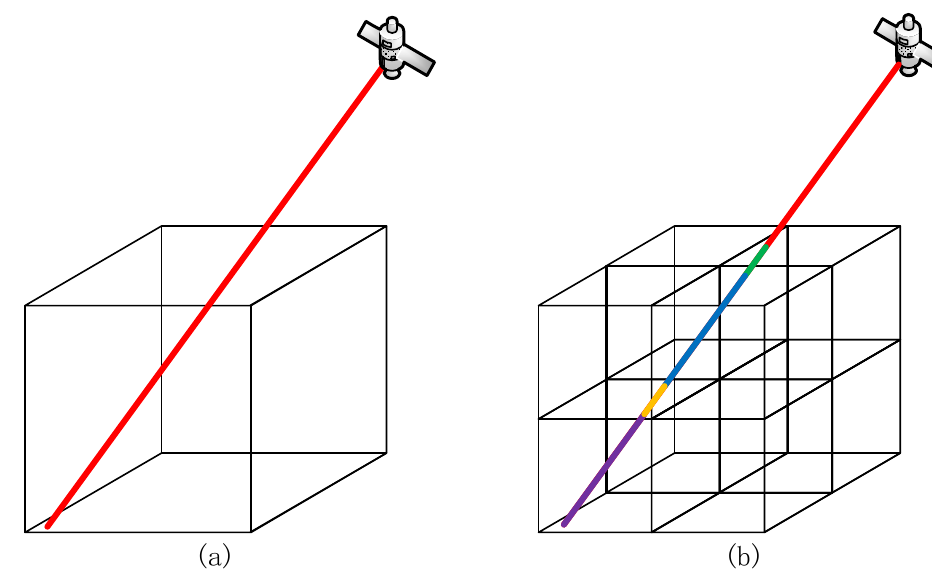
Figure 2. Valid ray: ( a ) valid ray penetrating from the top boundary of the tomography area and reaching the receivers; ( b ) valid ray discretized by voxels.